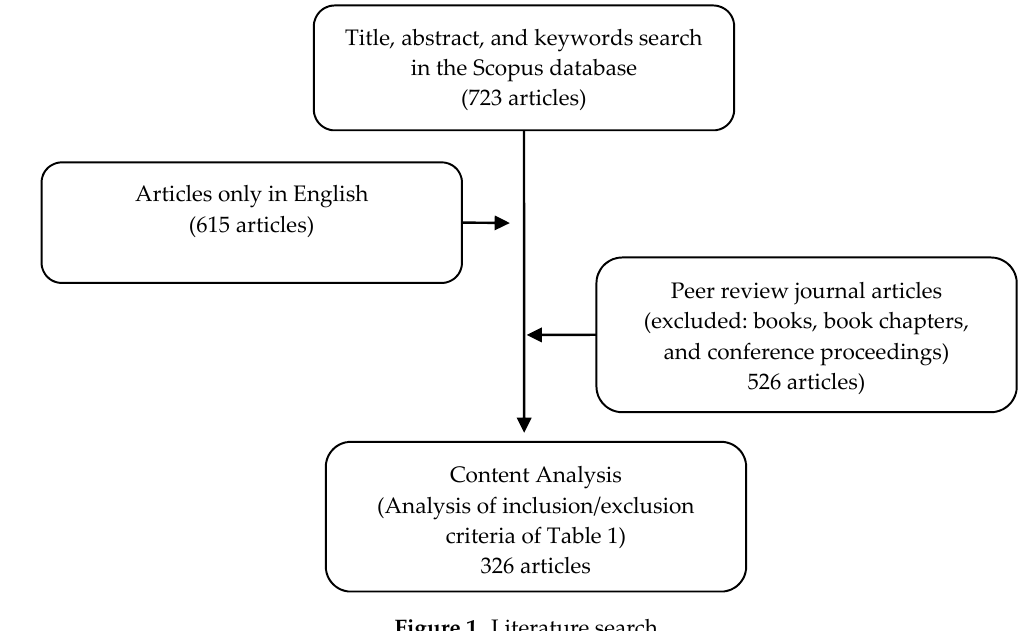
Table 1. Appraisal Step (ii): inclusion and exclusion